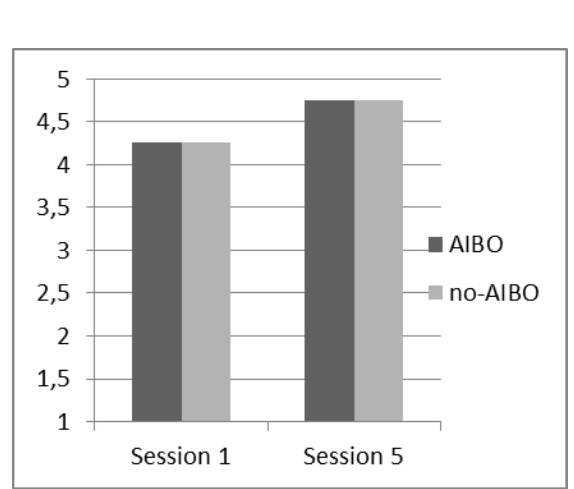
Figure 7. System difficulty for sessions 1 and 5 of each interaction mode (first and last interactions of no-AIBO and AIBO modes). Higher values indicate easier control and usage of the